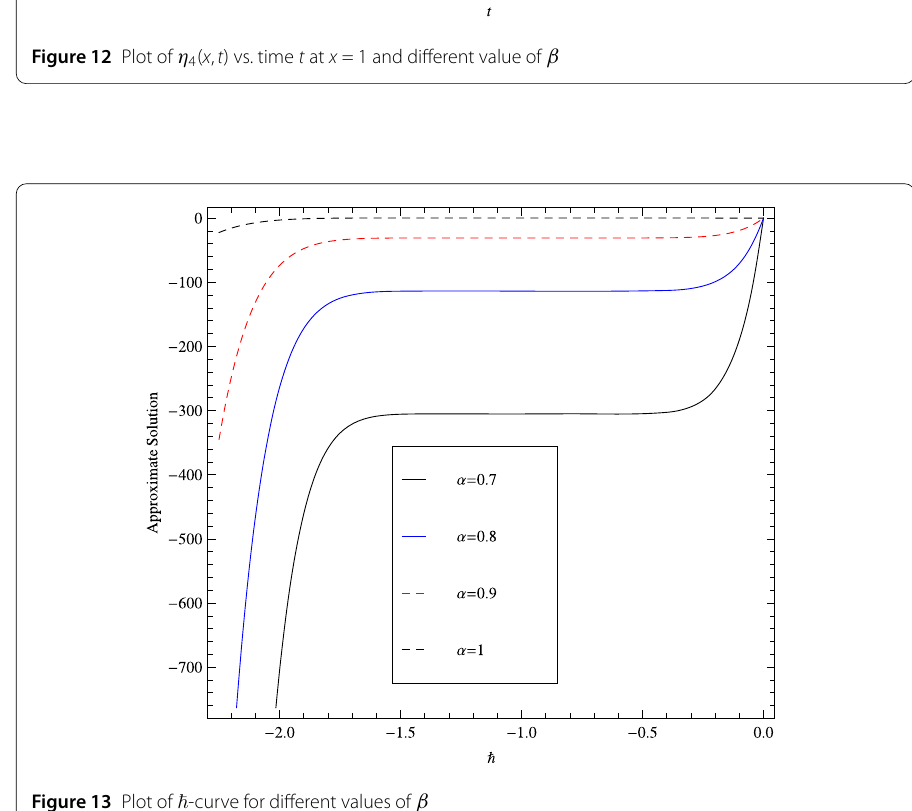
Figure 12 reflects the performance of the estimated solution ξ ( η , t ) for different values of λ